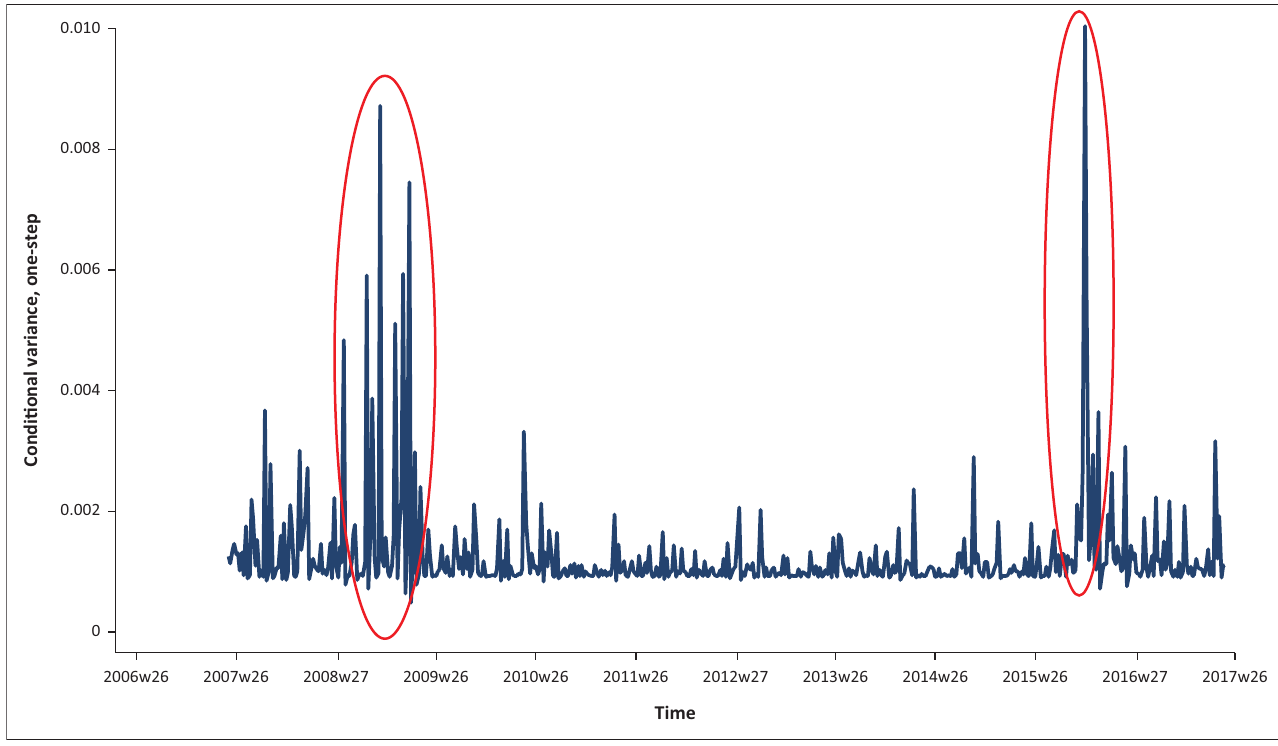
FIGURE 2: Conditional variance.